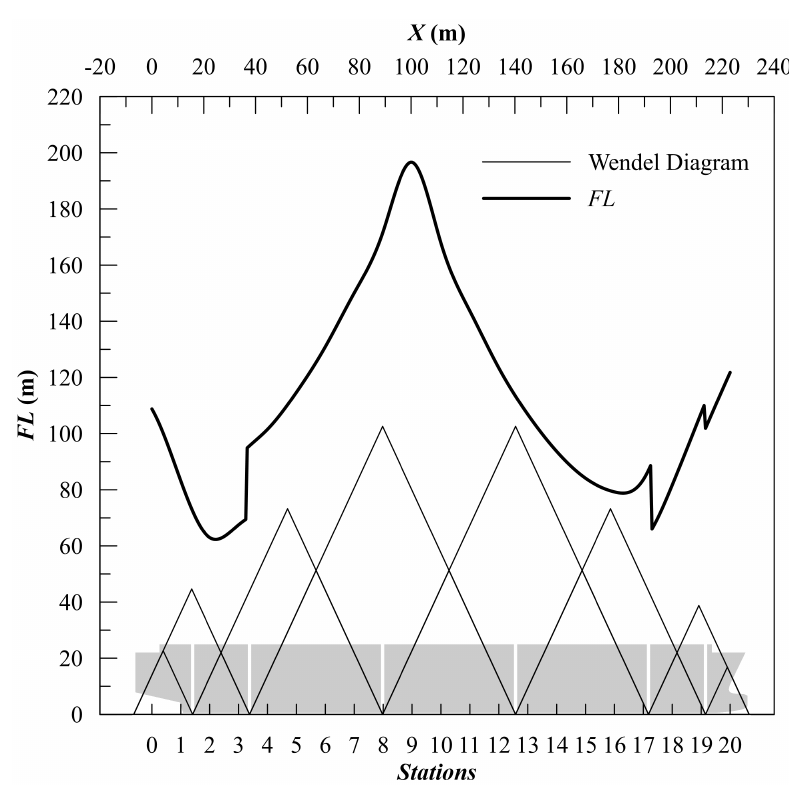
Figure 9. Equispaced subdivision: 3 cargo hold